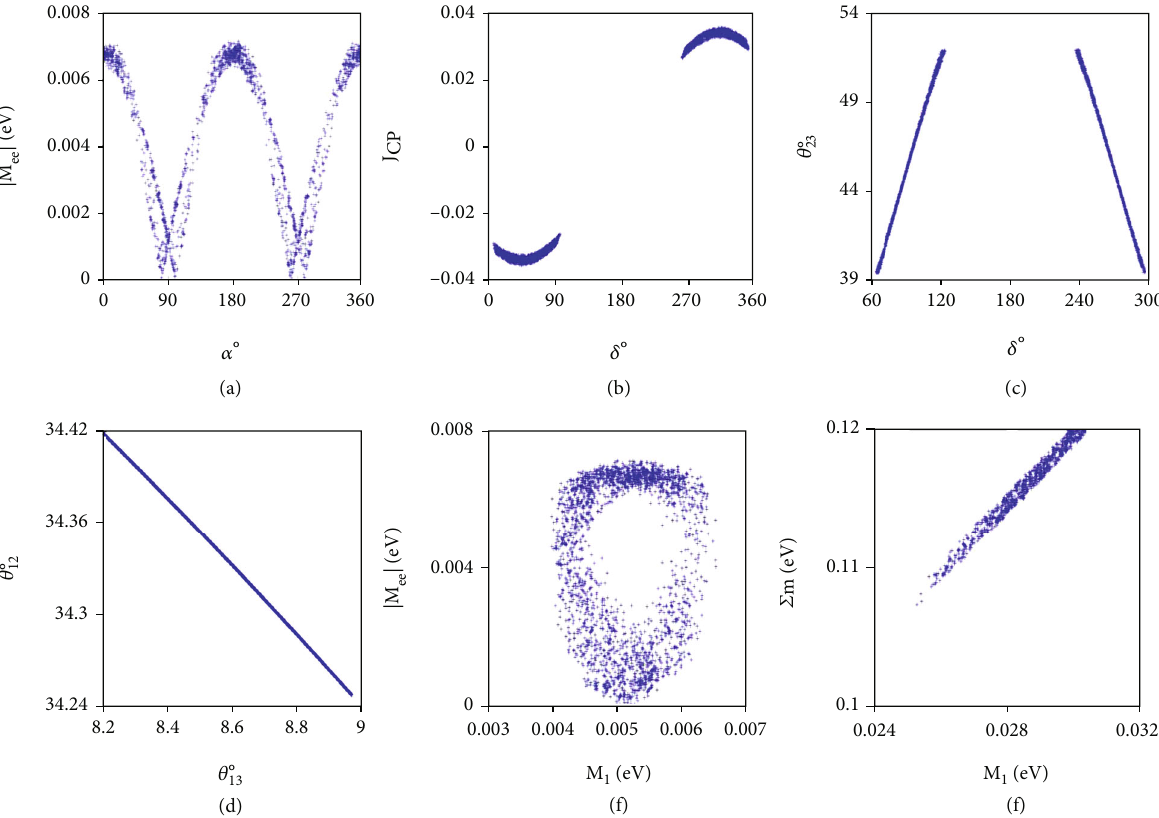
Figure 3: Correlation plots among various parameters for textures (a) M 1